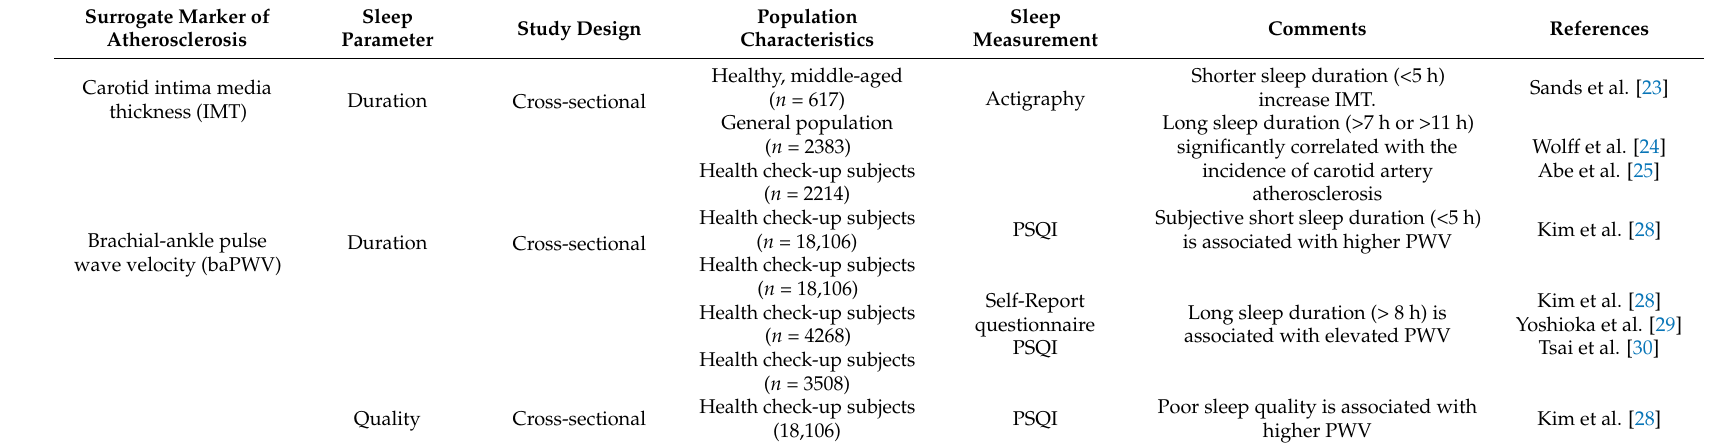
Table 2. Associations of subjective or objective sleep duration, and quality with carotid IMT and baPWV in healthy